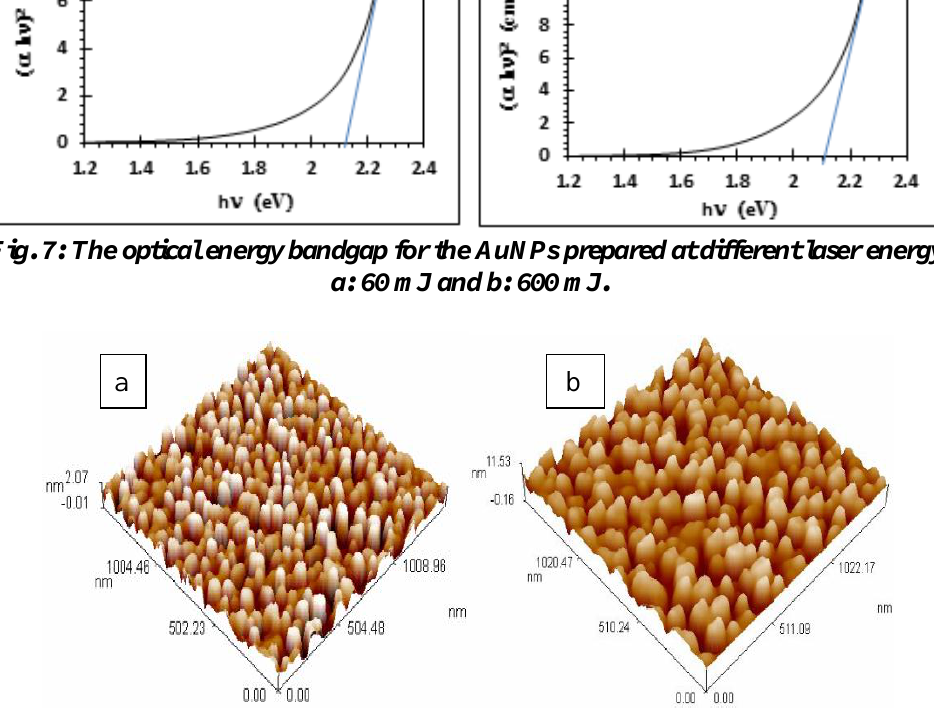
Fig. 8: 3D AFM image of AuNPs prepared at different laser energy, a: 160 mJ and b: 600